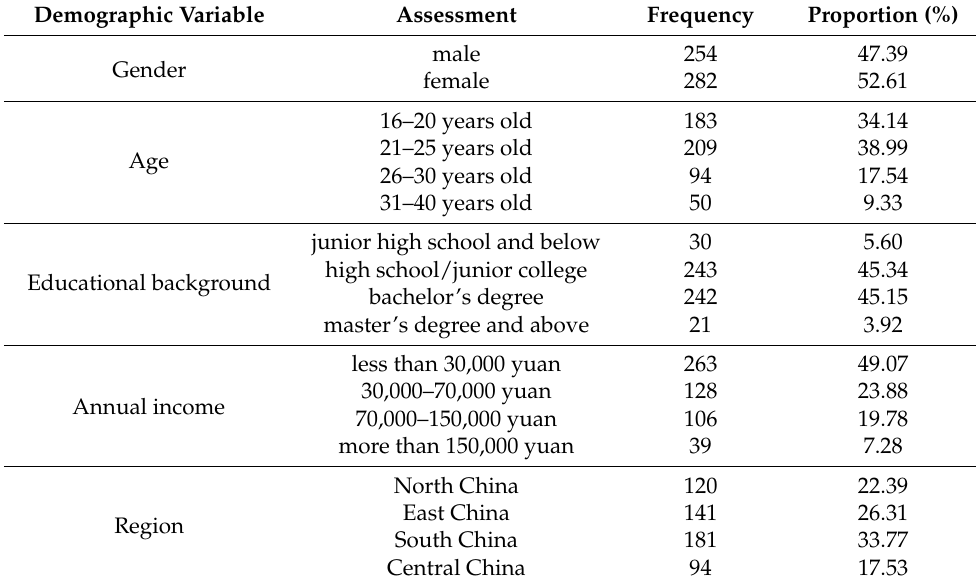
Table 2. Socio-demographic characteristics of respondents ( n =